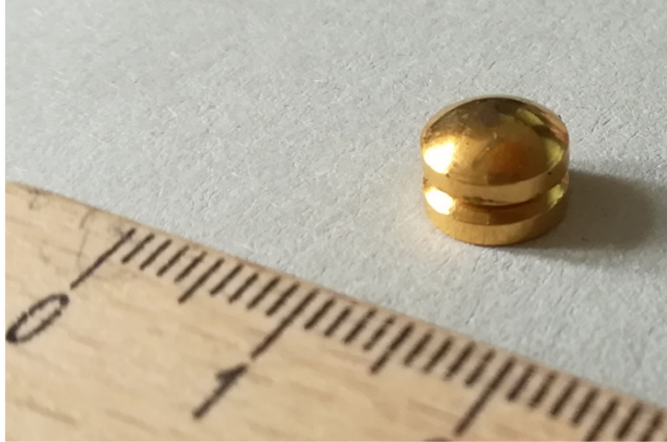
Figure 2. Pair of the newly designed magnets with convex-concave